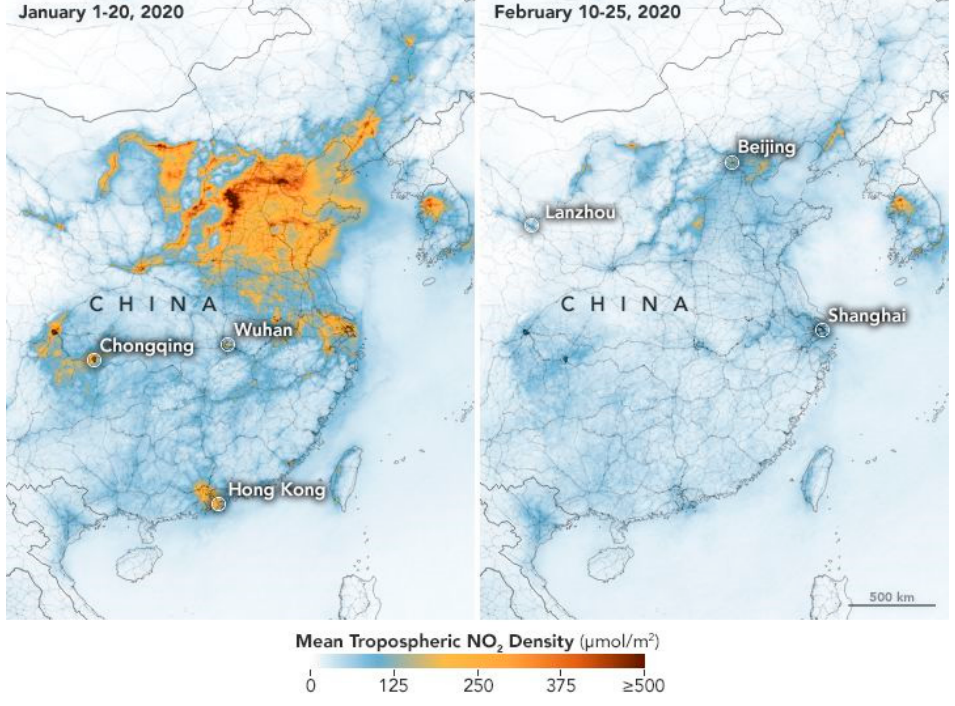
Figure 1. Satellite images of pollution levels over China, NASA [1].